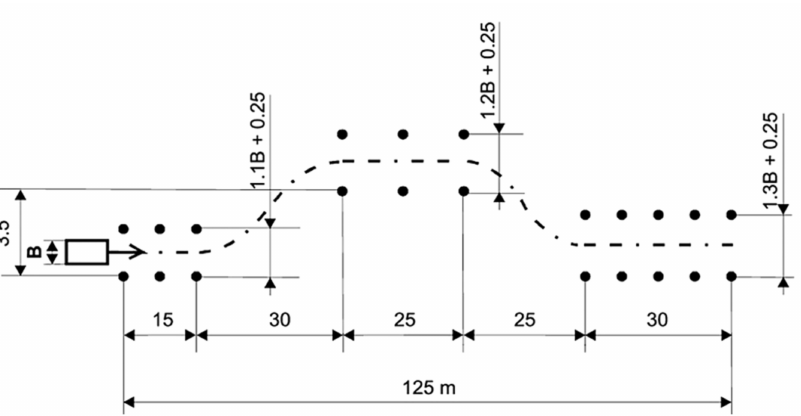
Figure 1. Cone displacement of the ISO 3888-1 double lane-change maneuver [2]; B represents the vehicle’s width (all the numerical values shown are to be intended in